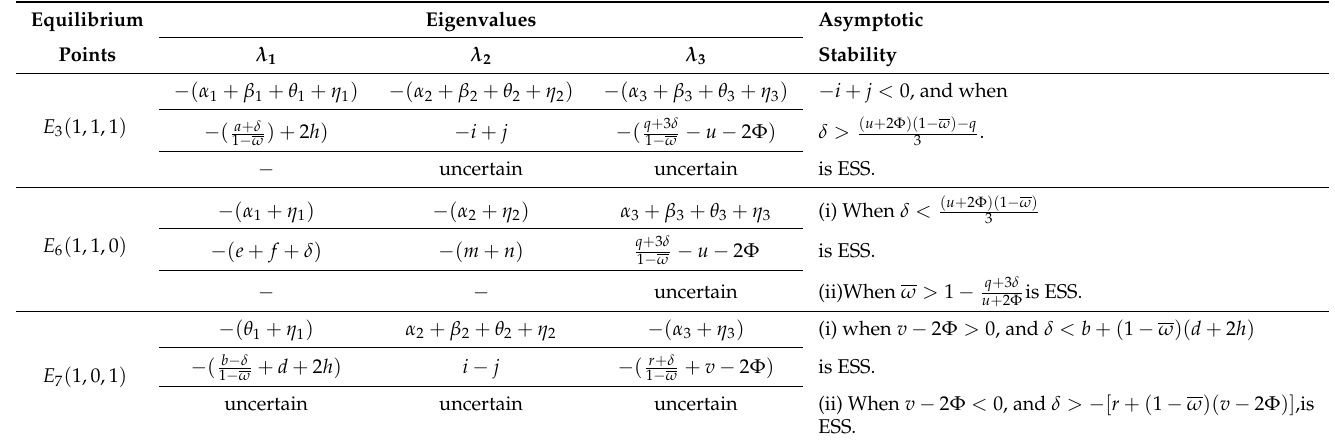
Table 5. Equilibrium points and stability